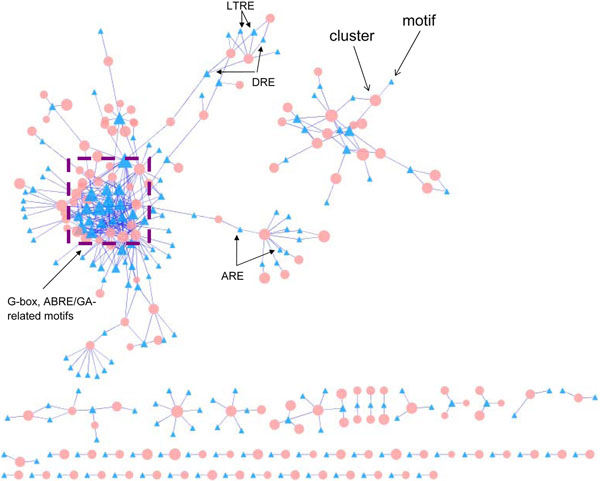
Arabidopsis cis-regulatory network. A circle represents a gene module. A triangle represents a motif. The size of a node is proportional to its module size or the number of modules it regulates.